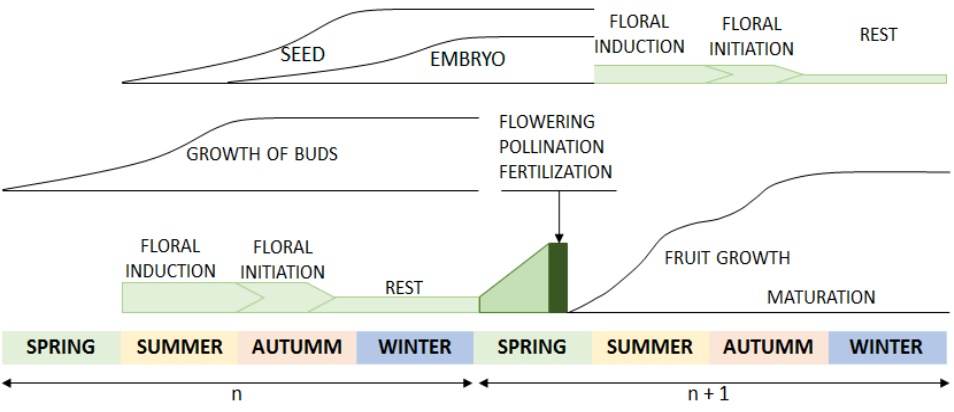
Figure 3. Vegetative and reproductive cycle of the olive